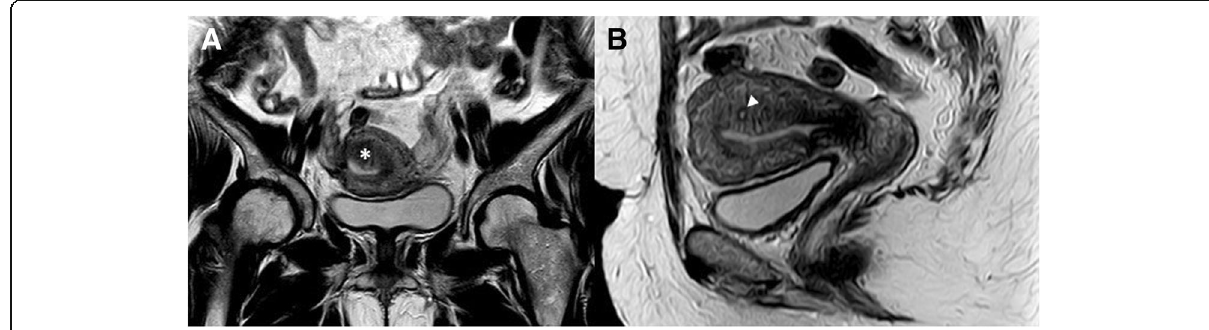
Fig. 2 Coronal ( a ) and sagittal ( b ) T2W 1.5-T pelvic MRI images of a 42-year-old female with persistent pelvic pain following cesarean section show focal thickening of the posterior uterine wall transitional zone (asterisk) with tiny myometrial cyst (solid arrow head), suggesting focal